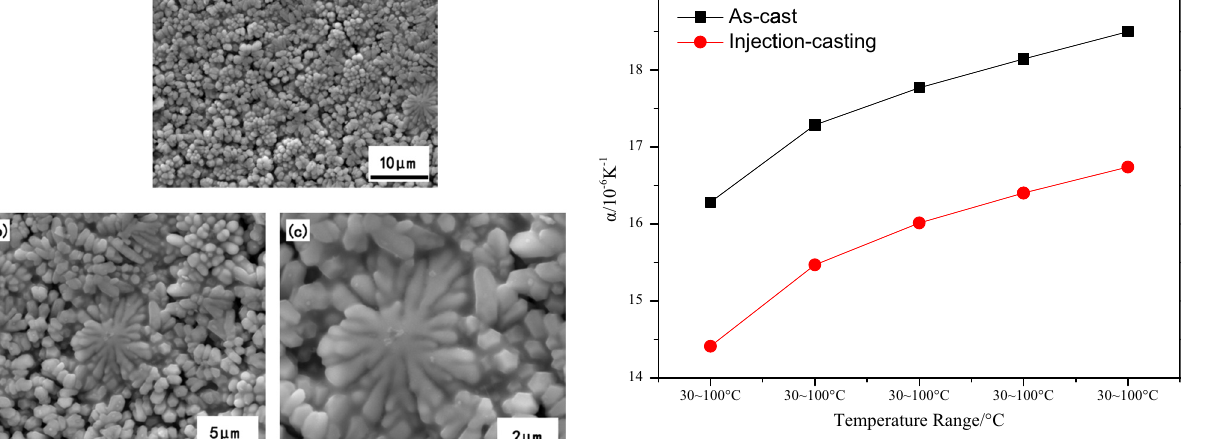
Figure 11: Morphology of Al – Mn – Fe alloy prepared by melt spinning.